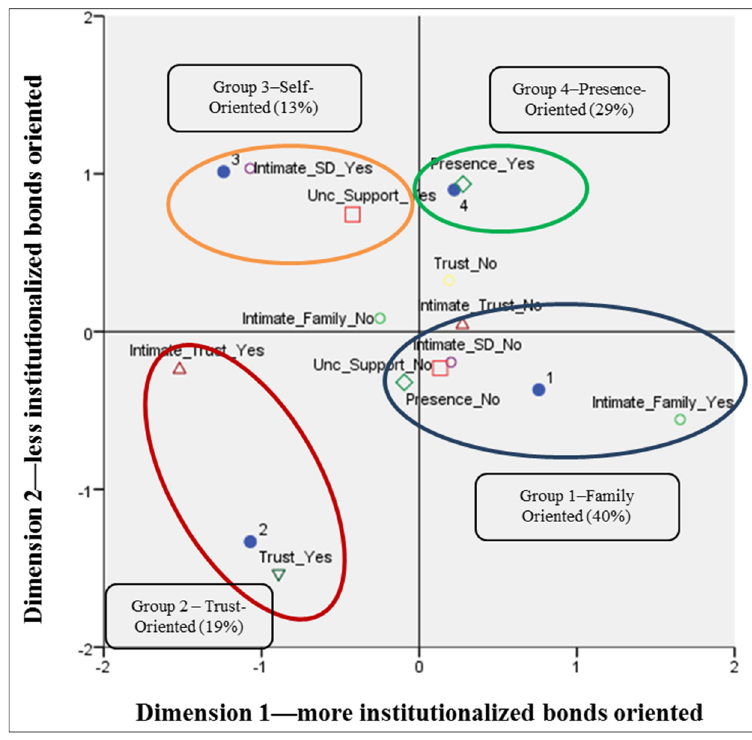
Figure 1. Meanings of friendship (multiple correspondence analyses, with clusters